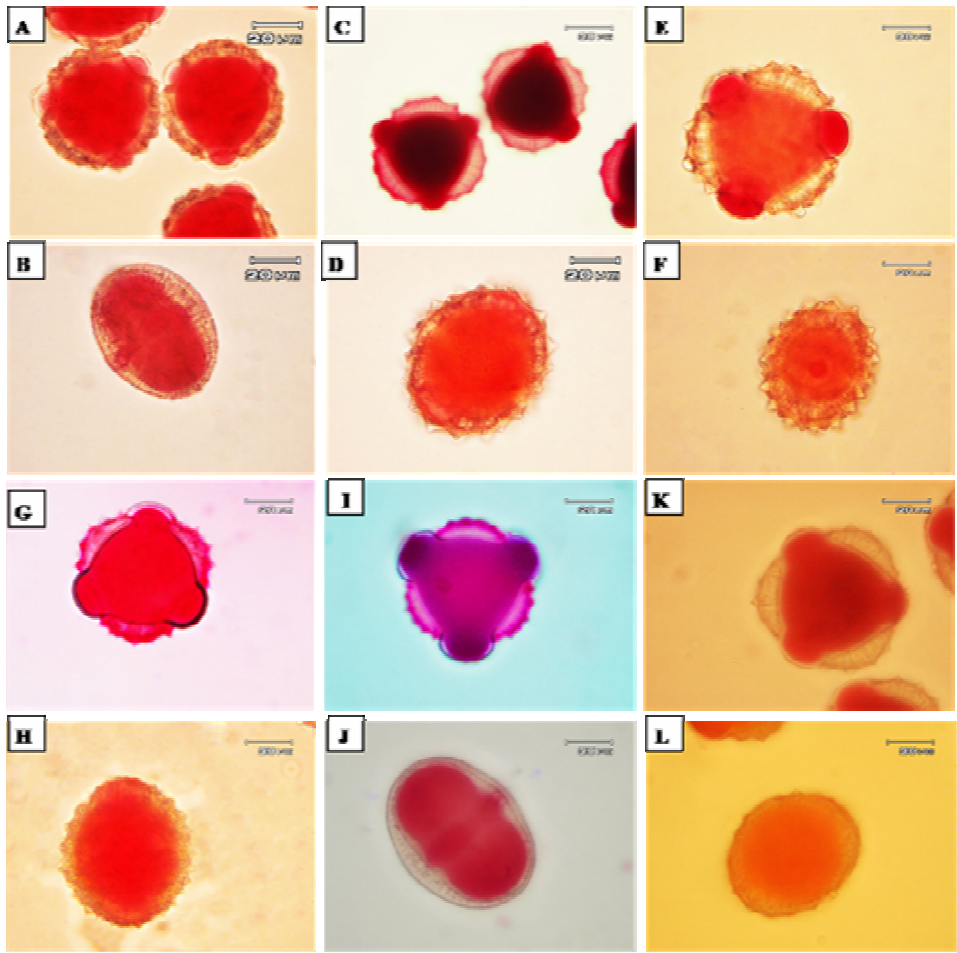
Fig. 8. Pollen grains in Onopordum species by light microscope. (A, B): O. acanthium , (C, D): O. carduchorum, (E, F): O. armenum , (G, H): O. leptolepis , (I, J): O. heteracanthum, (K, L): O. carmanicum . (Scale bar=20 µm, X= 400)